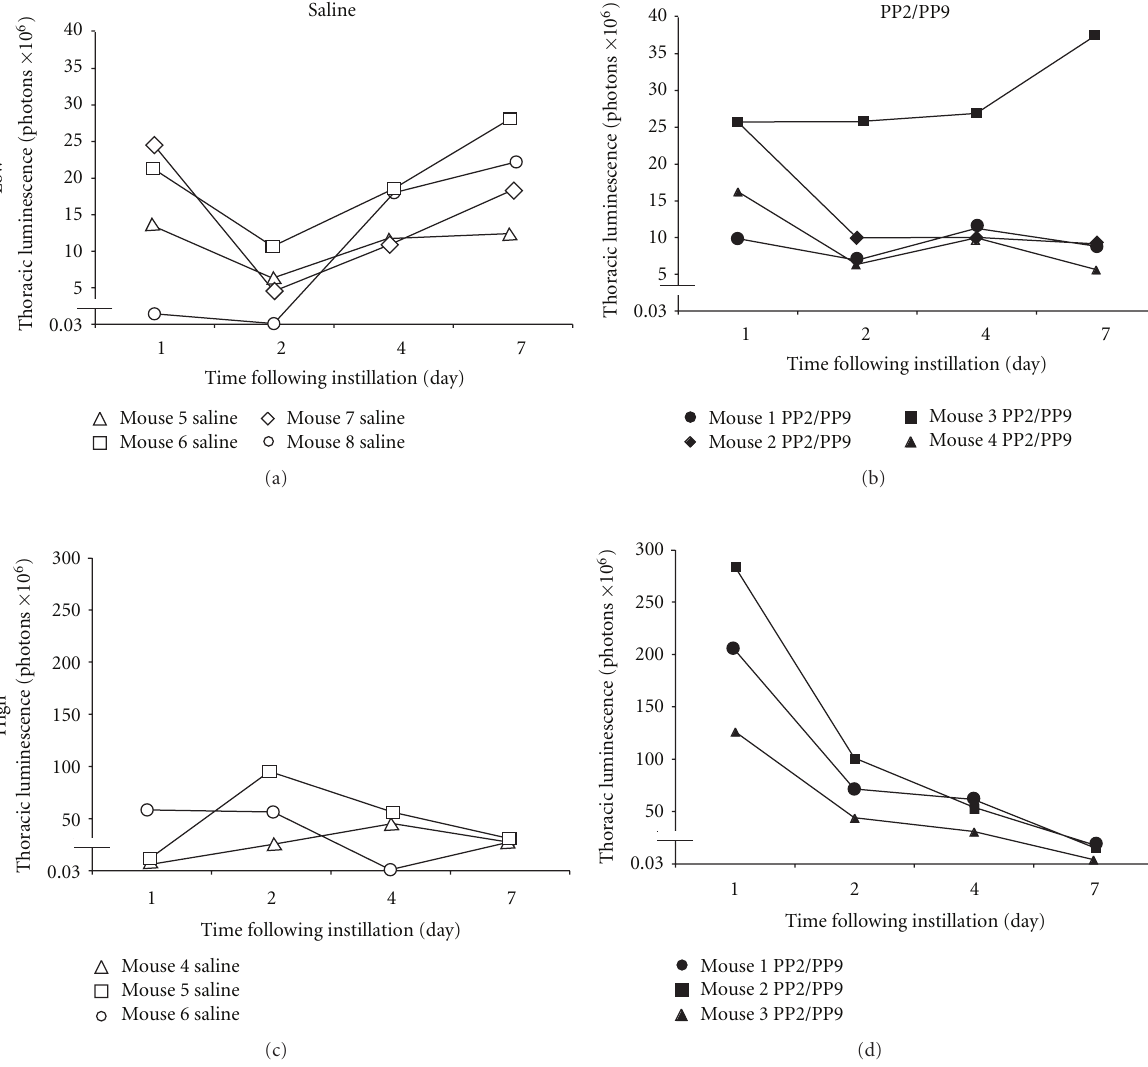
Figure 4: Comparison of luciferase activity in the lungs of mice. Mice were instilled with rAd-luc, and thoracic luciferase activity was quantified noninvasively over the course of 7 d. Two viral titers were administered 1 × 10 10 viral particles (Low) or 5 × 10 10 viral particles (High) in either saline or PFC liquid suspension. (a) 1 × 10 10 viral particles delivered in saline; (b) 1 × 10 10 viral particles delivered in PFC liquid; (c) 5 × 10 10 viral particles delivered in saline; (d) 5 × 10 10 viral particles delivered in PFC liquid. Each line represents the luciferase activity of a single animal. The images were acquired 10min after intraperitoneal delivery of luciferin (150 mg/kg). Luminescent images were acquired under identical settings (3min acquisition), and activity was assessed using an identical area (region of interest) and analyzed using the Living Image software package. The PFC liquid groups demonstrate a more consistent temporal pattern of expression compared to